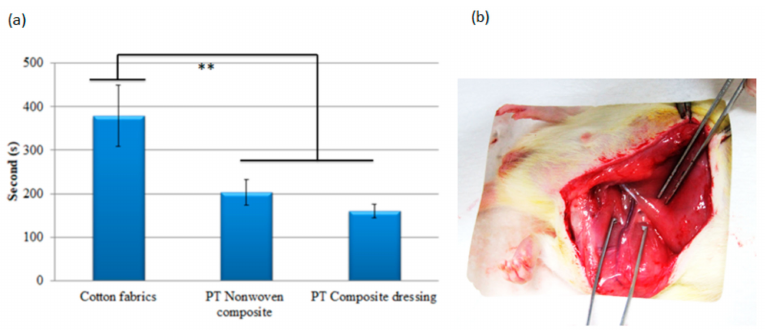
Figure 16. ( a ) Hemostasis time of cotton fabrics, PT nonwoven composite, and PT composite dressing in animal model, ** p < 0.01; ( b ) Hemorrhage from the cut in a rat’s femur